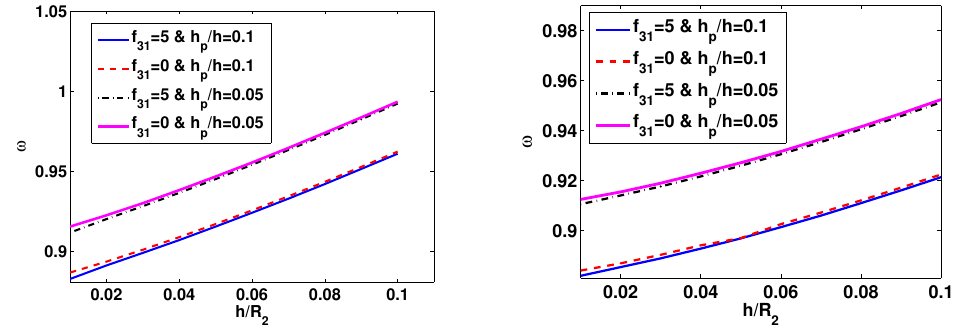
Figure 4. The effect of piezoelectric layer thickness and the flexoelectric effect on the frequency of FGM conical nanoshells ( α = 30, p = 1, k p = 1 × e − 3 , k w = 10 × e 12 , ( left ) clamped-clamped boundary conditions, ( right ) clamped-simply boundary conditions).